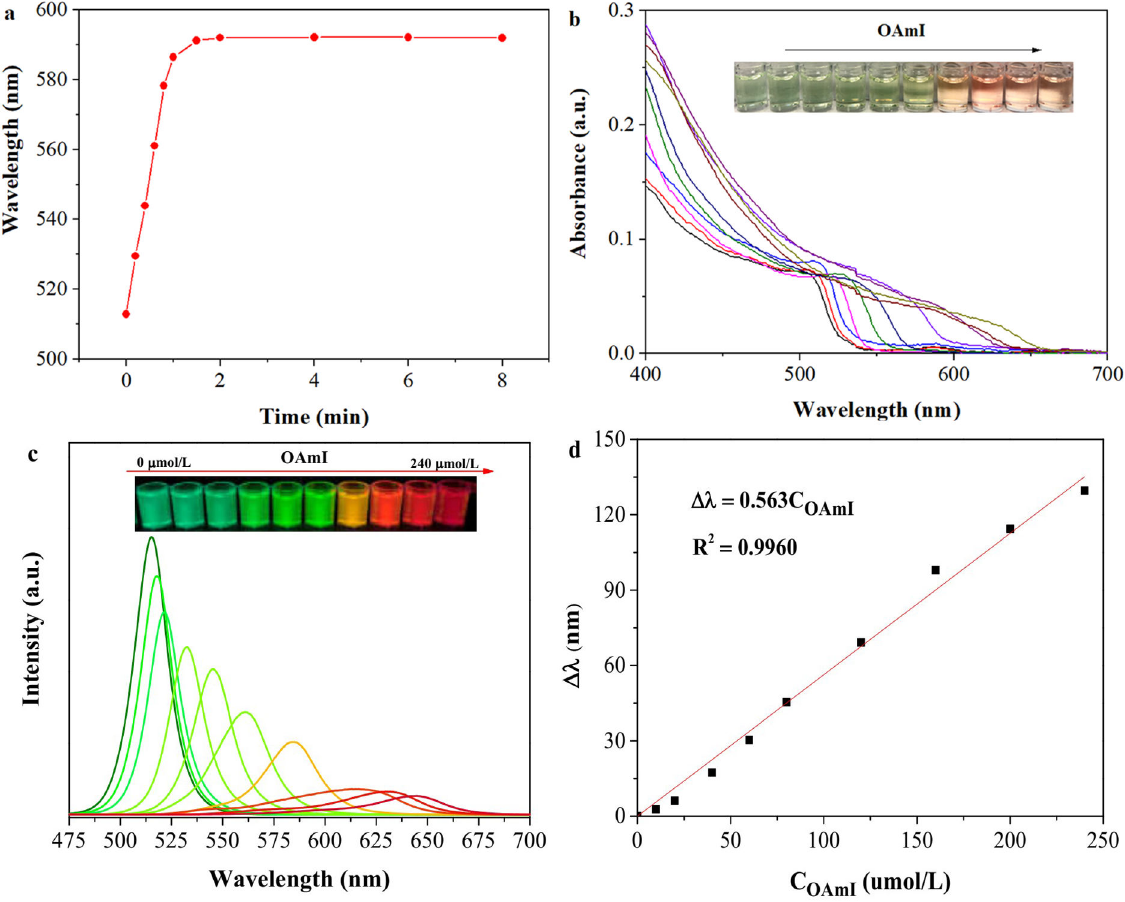
Figure 6. ( a ) The wavelength changes of CsPbBr 3 PNCs with halide exchanges of 120 µ mol L − 1 OLAM-I at different times; ( b , c ) the band edge absorption and PL spectra changes when CsPbBr 3 PNCs halide exchange with OLAM-I of different concentration from 0~240 µ mol L − 1 ; ( d ) the relationship between the concentration of OLAM-I and the wavelength-shift.